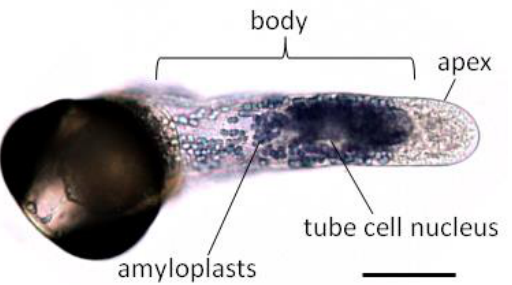
Figure 4. Picea pollen tube after 20 h of incubation in vitro. J 2 + KJ starch-specific staining. Bar—50 µm.